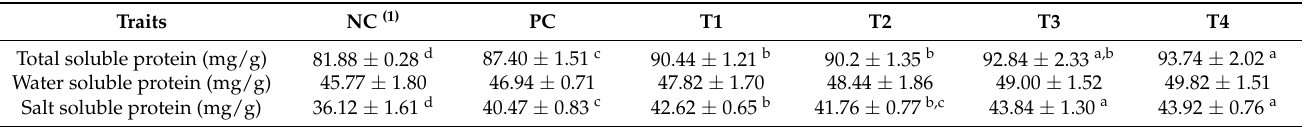
Table 3. Effects of grafted insect protein and eggshell powder on protein solubility of phosphate free meat